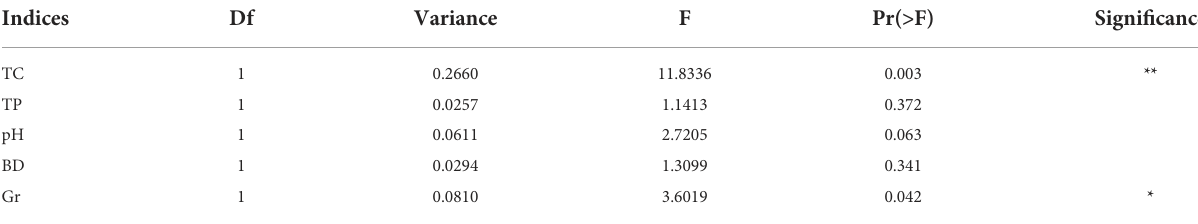
TABLE 4 Effects of environmental factors on bacterial community structure in non-degraded (ND), slightly degraded (SD) and heavily degraded (HD) alpine wetland areas. Indices Df Variance